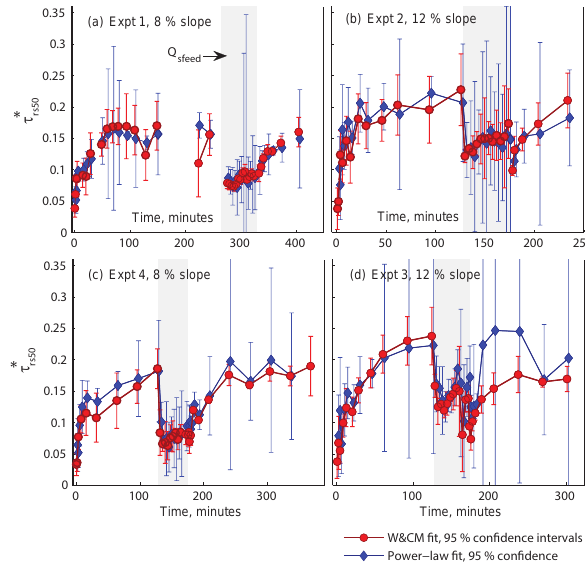
fits to the experimental data with the W&CM. Figure 3. τ ∗ rs50 “W&CM fit” uses Eq. (16) to calculate hiding function exponent b , while “Power-law fit“ calculates a best-fit b along with τ ∗ . Error rs50 bars give 95% confidence intervals on τ ∗ based on the regres- rs50 sions; although uncertainty can be broad the trends are clear and consistent. Shaded area indicates times of fine gravel addition (sed- iment feed) in each experiment. Data in these plots are available in Johnson